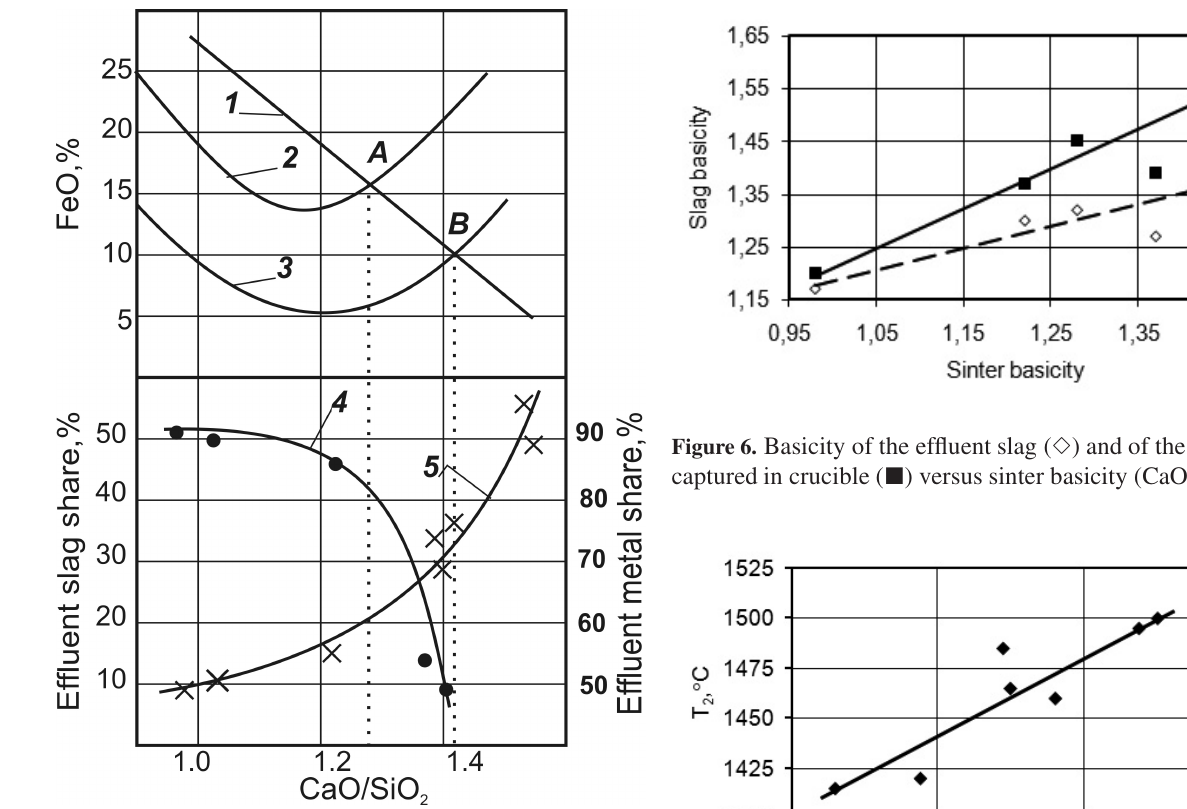
Figure 5. Influence of sinter basicity on the formation of fluid slag and metallic phases (signs are described in the text).